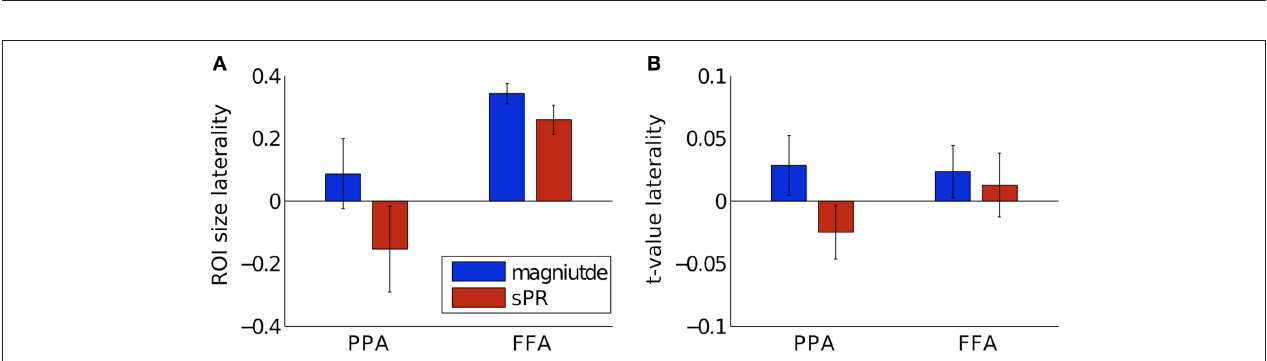
FIGURE 10 | Correlation between large vein contribution, ROI size, mean t -value. Each data point represents a single ROI from a single subject. (A) Large vein contribution metric 1 plotted against mean ROI t -value [ r = 0.40 , T (14) , p = 0.06 ]. Metric 1 is defined as: ROI size without minus with sPR large vein suppression. (B) Large vein contribution metric 2 plotted against mean ROI size [ r = 0.40 , T (14) , p = 0.06 ]. Metric 2 is defined as: mean ROI t -value without minus with sPR large vein suppression. These results suggest that ROIs higher in fSNR and larger in size tend to have larger contributions from large veins.